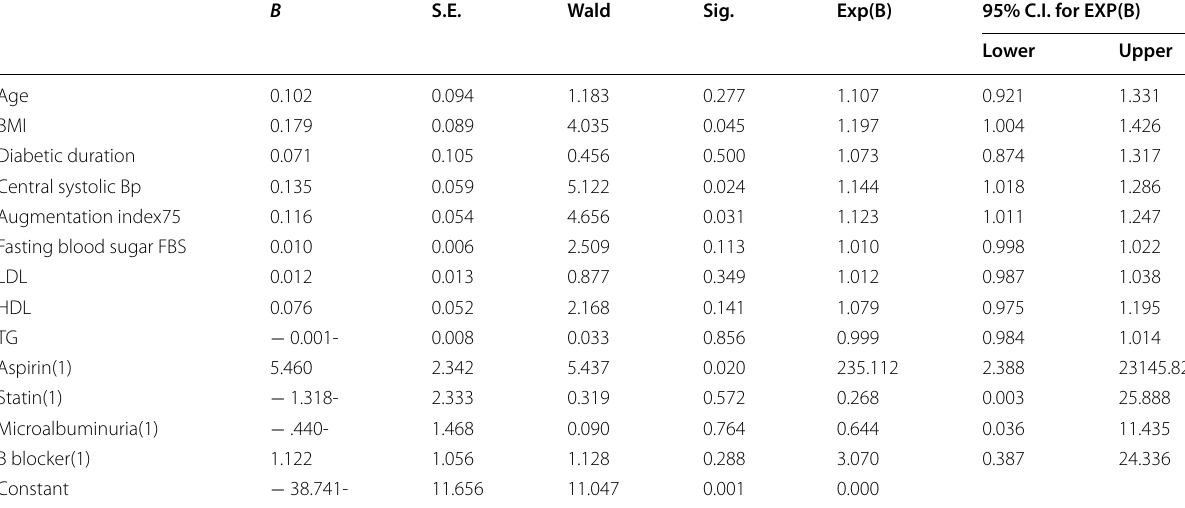
Table 2 Logistic regression analysis displaying independent predictors of the occurrence of composite CVD in diabetic